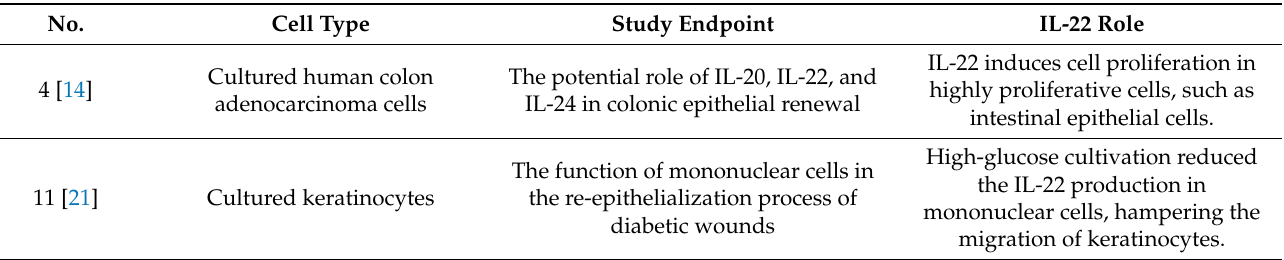
Table 2. Cell culture studies included in the systematic review.